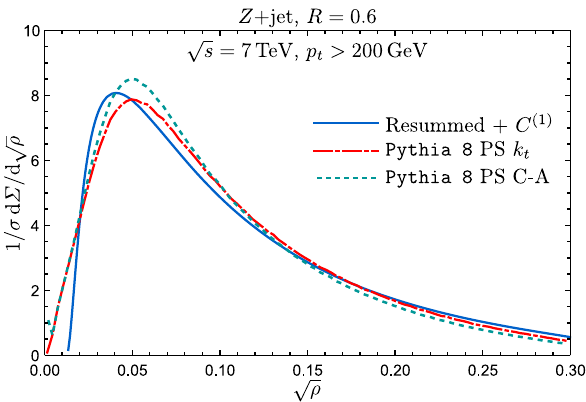
Fig. 10 Resummed differential jet mass distribution in Z + jet events with C–A algorithm compared to Pythia 8 PS